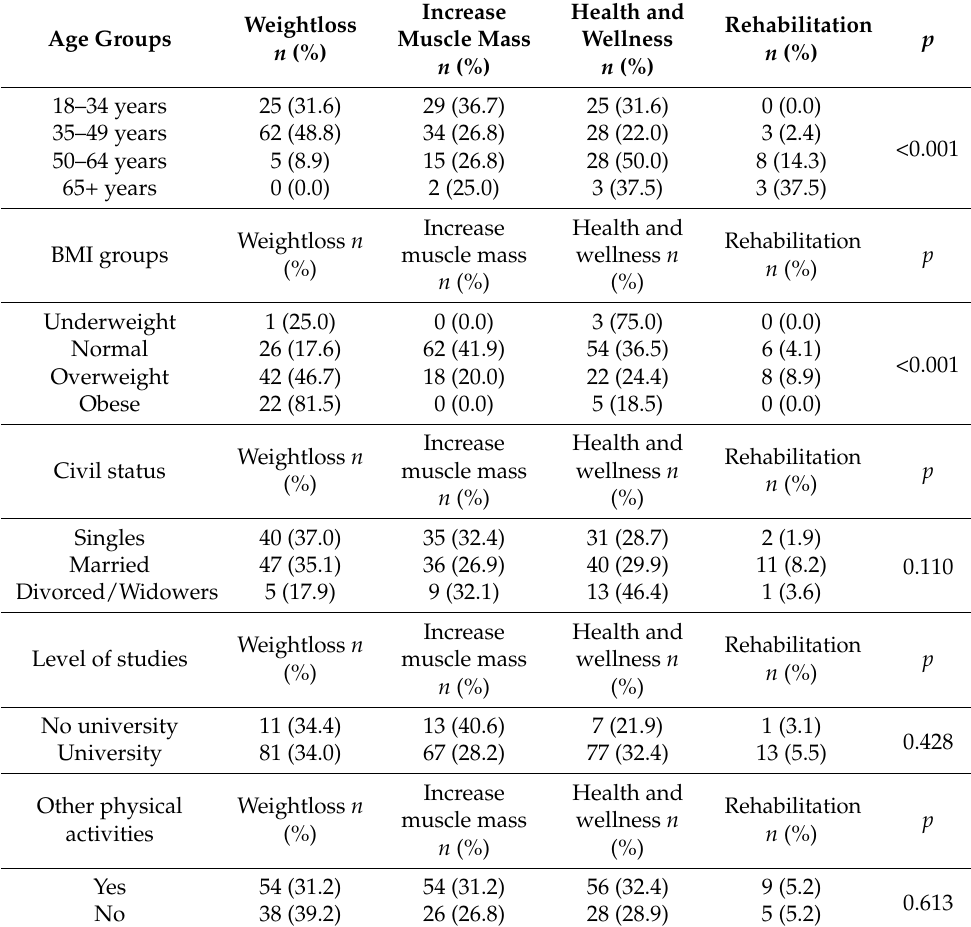
Table 2. Relationships between socio-demographic variables and training